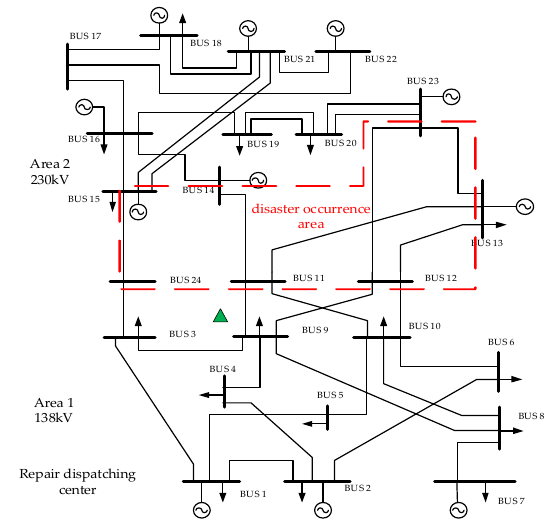
Figure 3. The system topology of the IEEE RTS 79 test system.